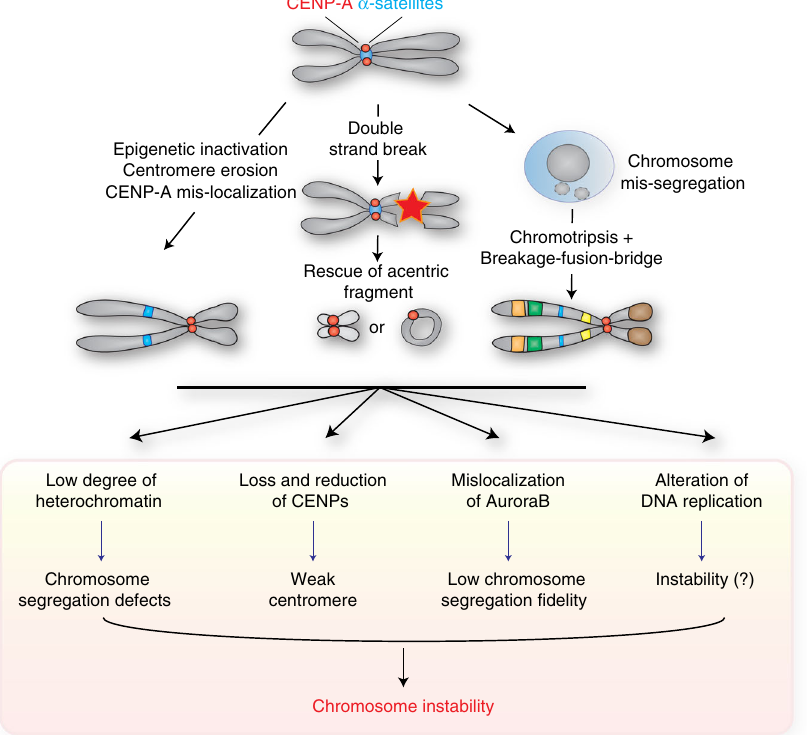
Fig. 3 Neocentromeres and chromosome instability. A neocentromere forms at chromosomal locations different from the centromere ’ s original position. The possible causes of neocentromere formation, depicted here, span from epigenetic inactivation, centromere erosion, CENP-A mislocalization to rescue of acentric DNA fragments following chromosome rearrangements. Neocentromeres display, however, a low degree of heterochromatin, loss and reduction of centromeric proteins (CENPs), mislocalization of Aurora B and alteration of DNA replication that cause a decrease in chromosome segregation fi